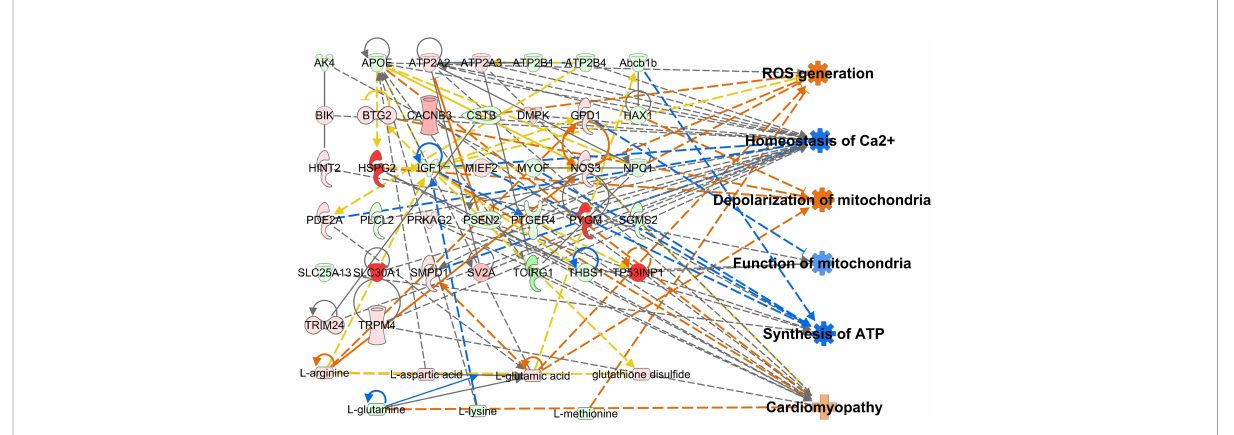
FIGURE 4 Metabotranscriptomic network with an in silico prediction of PM 2.5 -treated HL-1 cells. The network was generated using IPA. Green and red indicate downregulated and upregulated genes and amino acids, respectively. Dotted and solid lines indicate indirect and direct relationships, respectively. Details for shape and color are provided in Supplementary Figure 1 and Figure 2B.